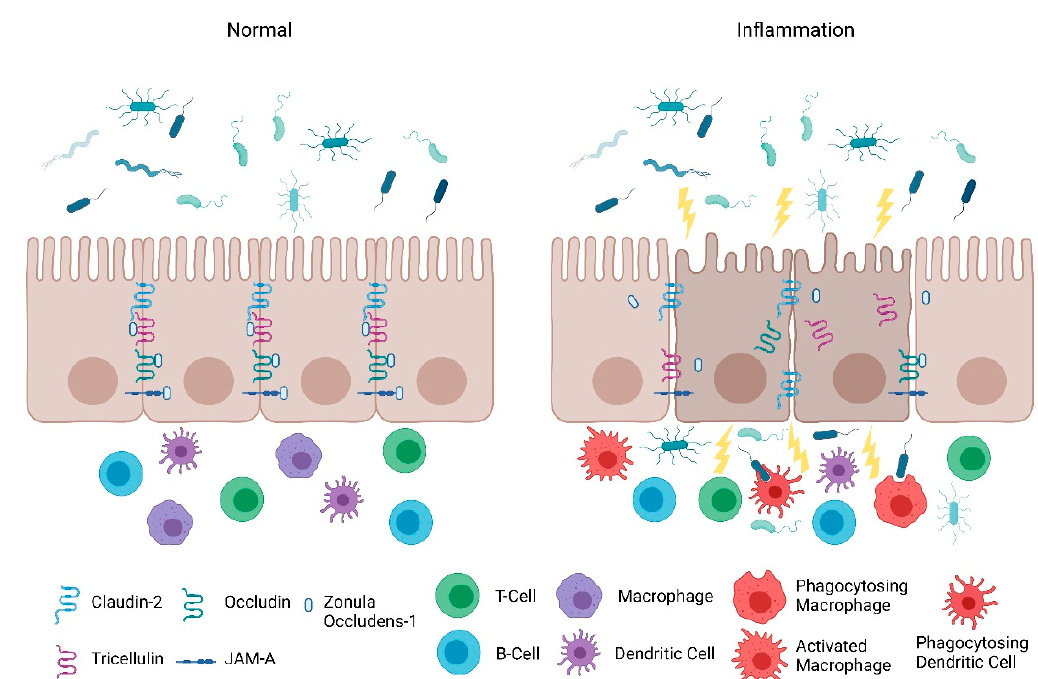
Figure 1. Intestinal permeability leads to intestinal inflammation. Tight junctions are the primary regulator of intestinal paracellular permeability and act as a selective ‘gate’ for nutrients and fluids while preventing passage of foreign antigens. Alterations in expression and localization of tight junction proteins can lead to increased intestinal permeability and provide a pathway for paracellular access of luminal pathogenic agents to lamina propria immune cells, in addition to loss of electrolytes and fluid. Accumulation of these agents can potentially overwhelm the underlying immune system and collectively cause intestinal inflammation. This illustration was made using BioRender.